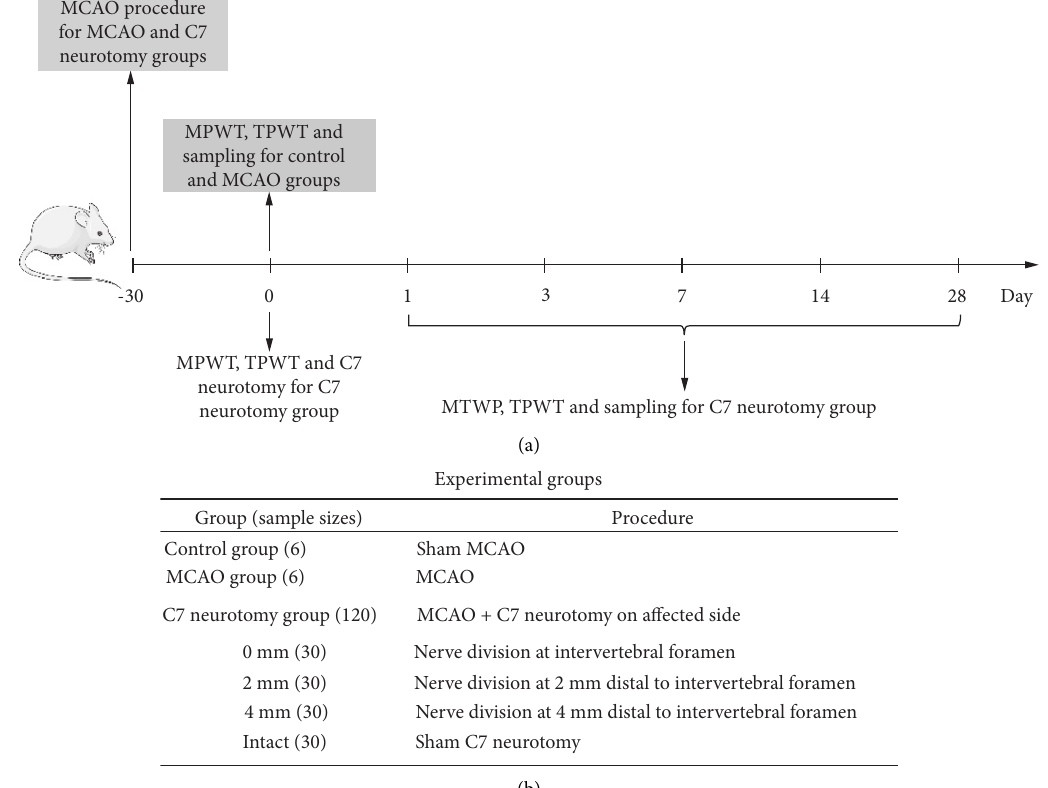
Figure 1: Schematic illustration of the (a) study timeline and (b) experimental groups. MCAO, middle cerebral artery occlusion; MPWT, mechanical paw withdrawal threshold; TPWT, thermal paw withdrawal